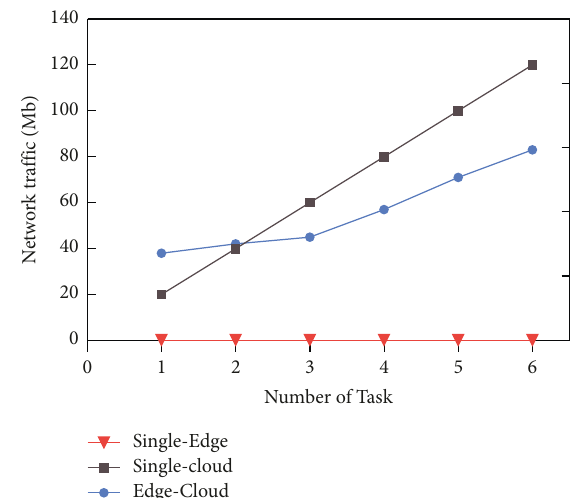
Figure 3: Comparison of the network transmission volume of the three schemes under the same number of tasks.